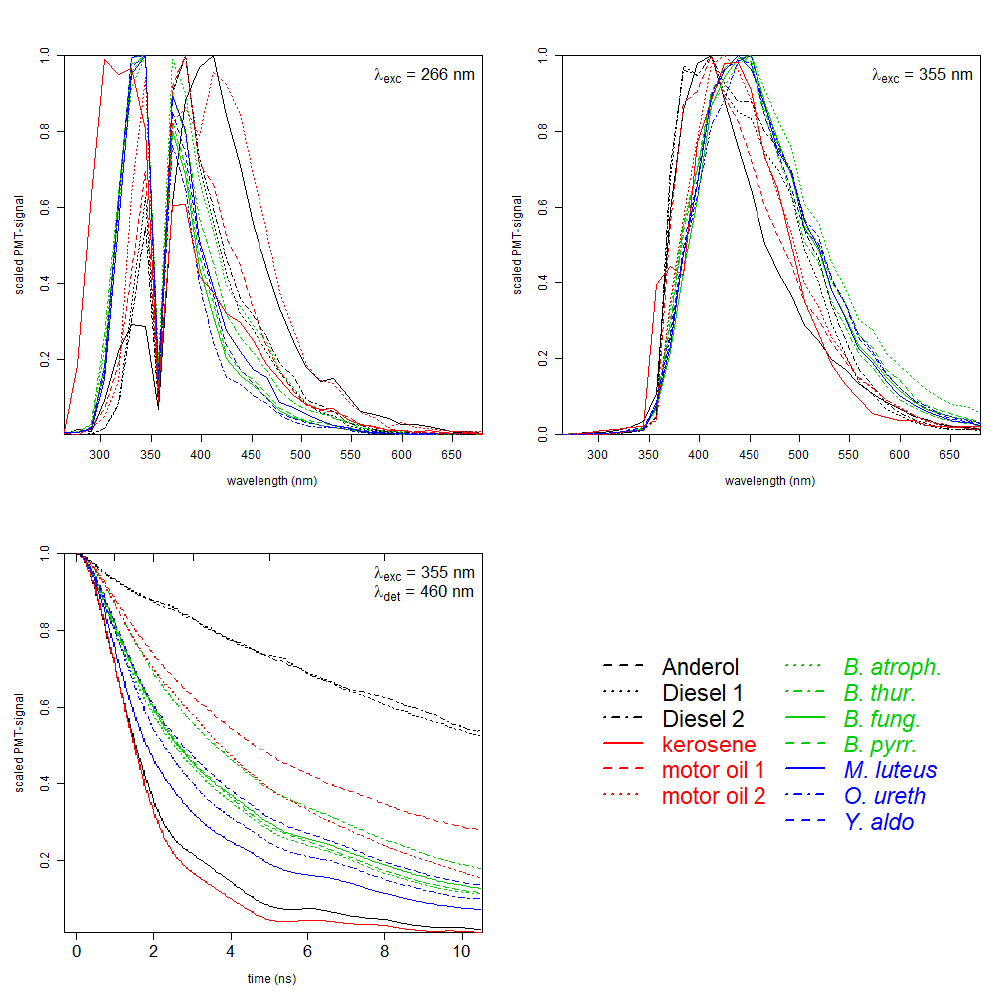
Figure 2. Measured dataset for seven different bacteria and six commercially available oils. Upper graphs: Fluorescence spectra with λ exc = 266 nm and λ exc = 355 nm, respectively. Lower graph: time-resolved data ( λ exc = 355 nm, λ det = 460